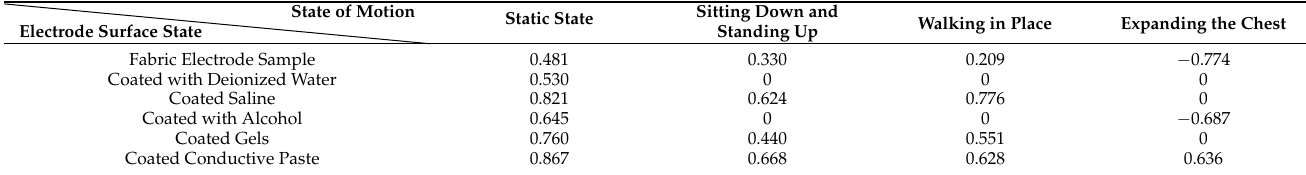
Table 1. The correlation coefficient between the ECG pattern corresponding to the cotton fabric electrode and the disposable gel